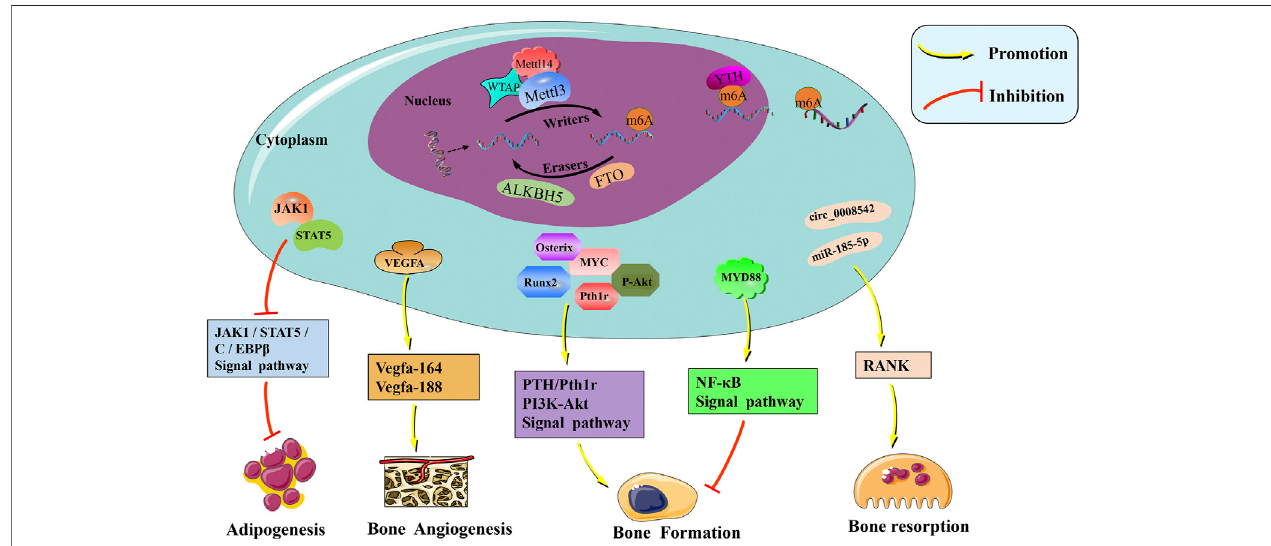
FIGURE 1 | The molecular mechanism and physiological regulation roles of m6A modi fi cation in bone. M6A is mainly catalyzed by the METTL3 – METTL14 – WTAP methyltransferase complex, and the demethylases ALKBH5 and FTO remove the methyl group of m6A off RNAs. Readers of the YTH domain family are effectors that recognize the m6A methylation code and convert it into signals. M6A modi fi cation regulates the expression of Runx2, Osterix, VEGF, RANK, and other related genes affecting bone metabolism. Furthermore, PTH/Pth1r, PI3K-Akt, NF- κ B, and other signaling pathways were also mediated by m6A, which is important in the regulation of bone